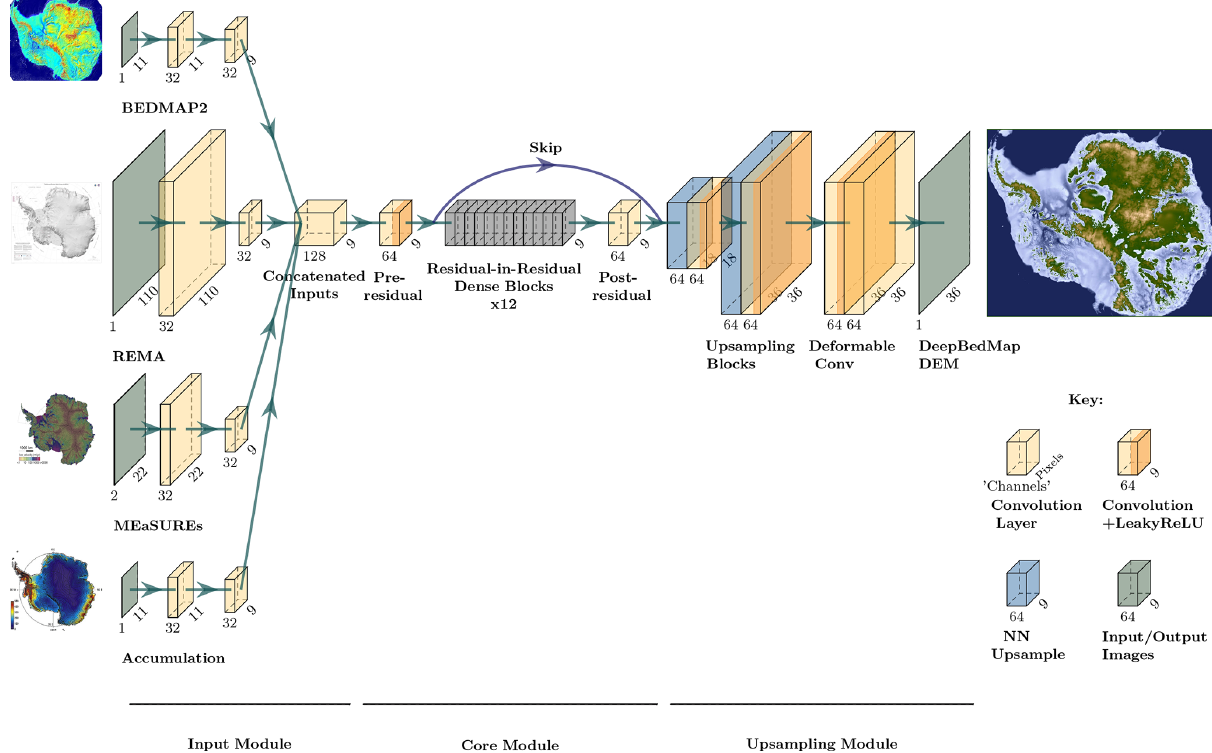
Figure 1. DeepBedMap generator model architecture composed of three modules. The input module processes each of the four inputs (BEDMAP2, Fretwell et al., 2013; REMA, Howat et al., 2019; MEaSUREs Ice Velocity, Mouginot et al., 2019b; snow accumulation, Arthern et al., 2006; see also Table 2) into a consistent tensor. The core module processes the rich information contained within the concatenated inputs. The upsampling module scales the tensor up by 4 times and does some extra processing to produce the output DeepBedMap_DEM.